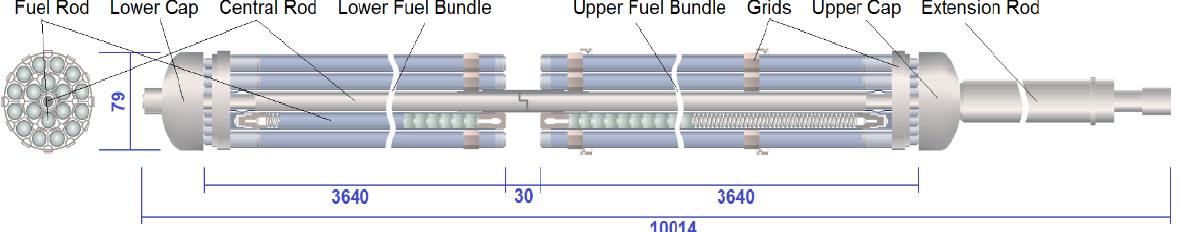
Figure 1. Cross-sections of the dry storage containers (1—container body (1a,b,d,e,f—metal parts; 1c—heavy concrete); 2—basket; 3—container lid; 4 (4a,b)—guard plates).